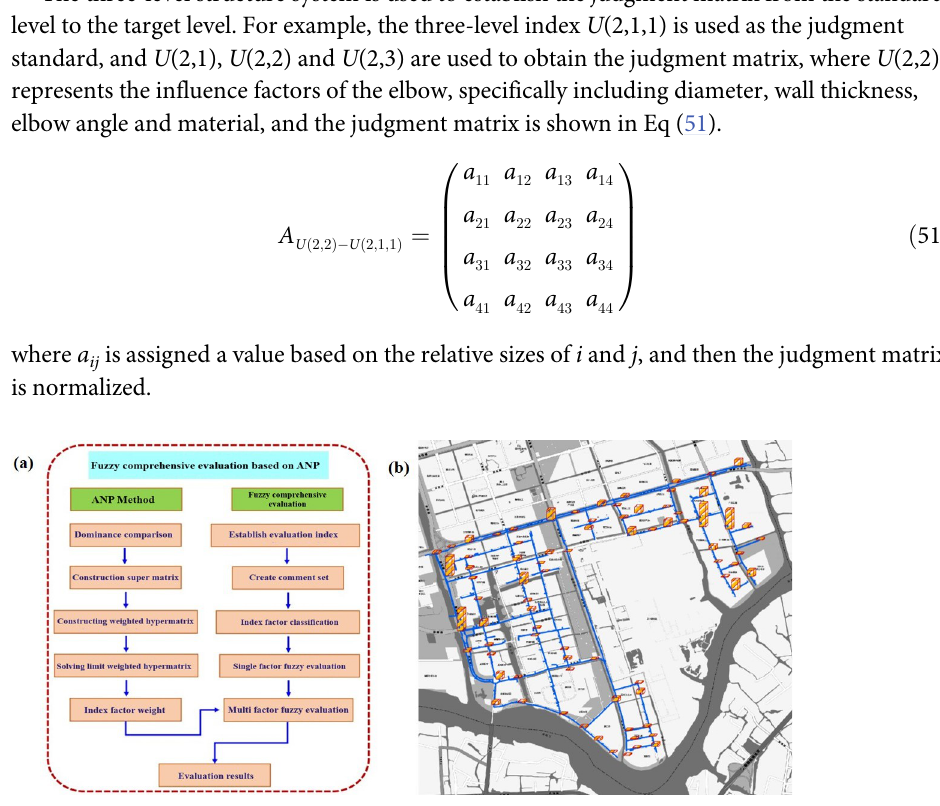
Fig 19. Fuzzy comprehensive evaluation method based on ANP. (a) Calculation flow chart, (b) Risk calculation results of pipeline network in Shengpu subregion. (Republished under a CC BY license, with permission from Suzhou Industrial Park Qingyuan Huayan Water Co. LTD, original copyright